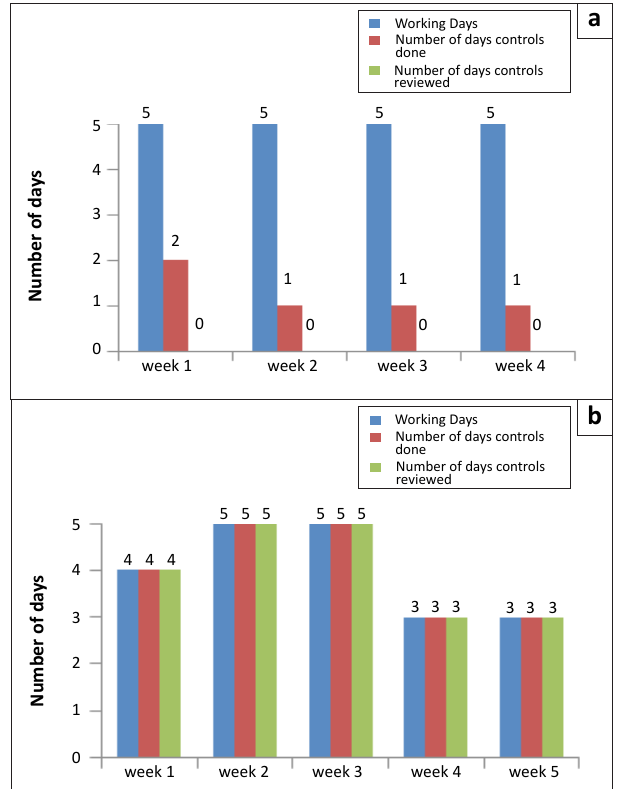
FIGURE 4 : Example of an improvement project (from cohort 2) on improving performance and reviewing the internal quality control for CD4 the CD4 Section using a Cyflow analyser, indicating (a) the baseline data from February 2010 and (b) the final data at project completion in June 2010.